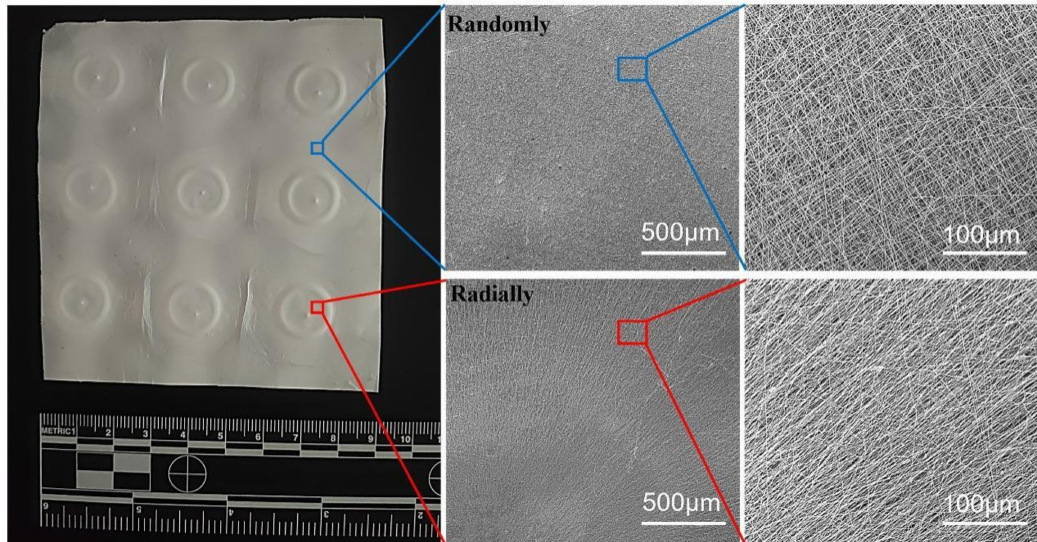
Figure 4. Photograph and SEM images of as-prepared PHBV nanofiber scaffolds with both randomly and radially oriented patterns.